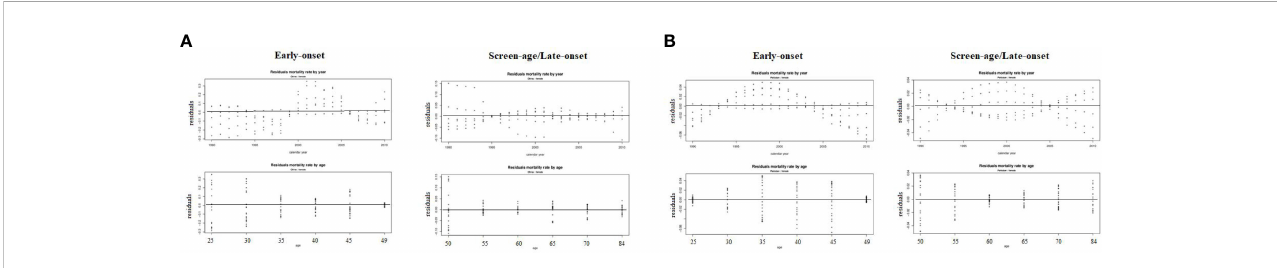
FIGURE 4 Residuals mortality rates by age and year from the LC model between the early-onset and screen-age/late-onset population in (A) China and (B)